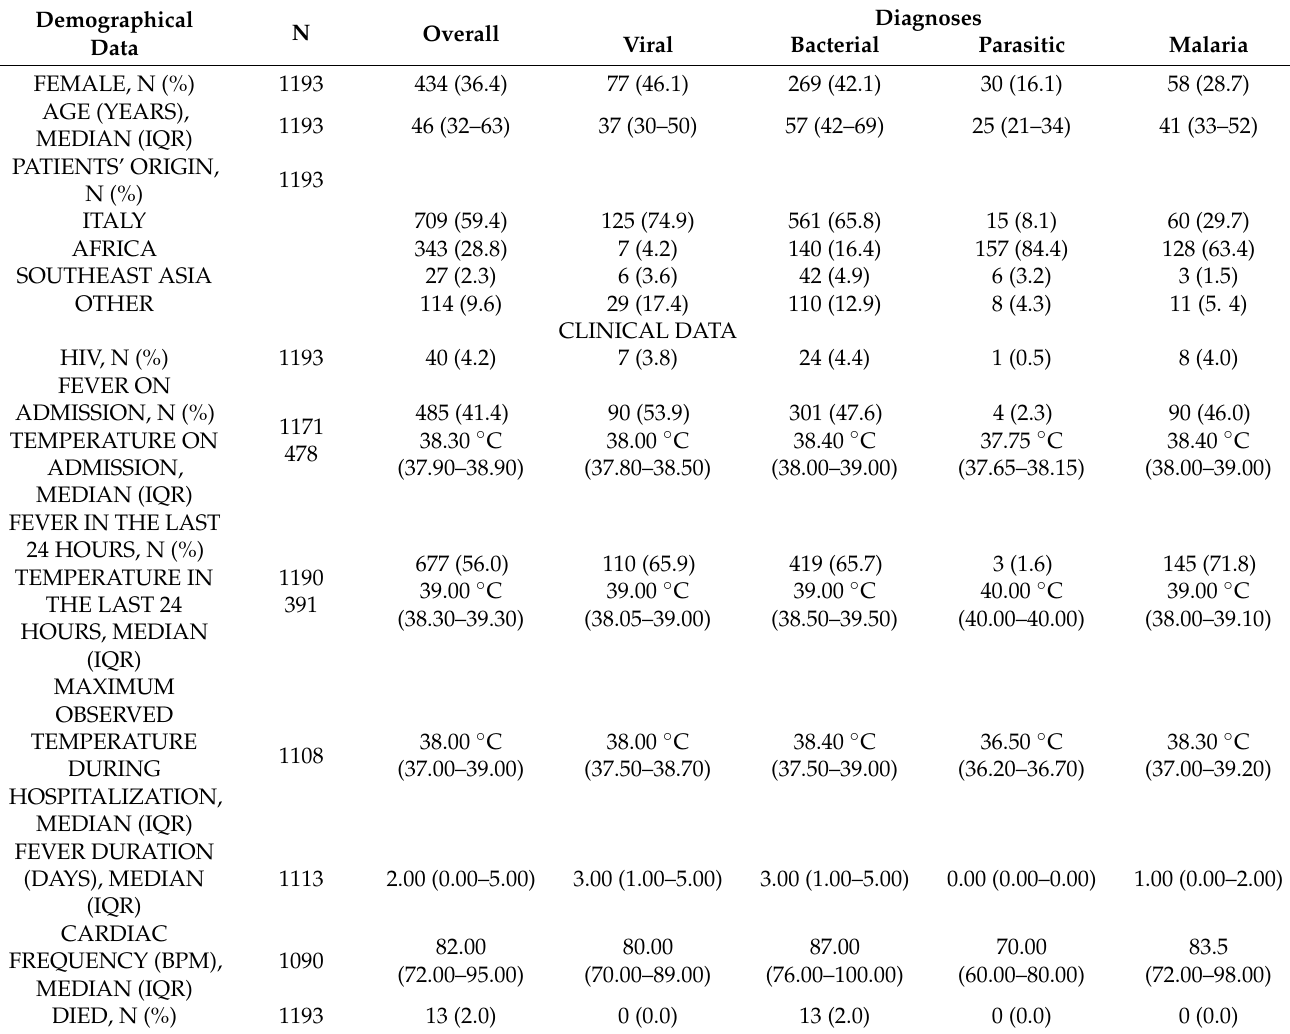
Table 3. Main characteristics of the included